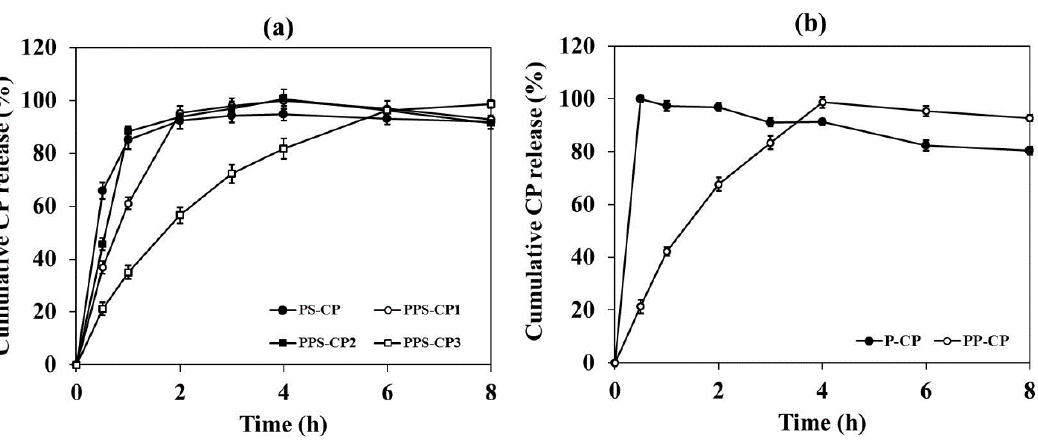
Figure 4. In vitro release of CP from CP-ENFs obtained from various EFASs with ( a ) and without ( b ) silica.